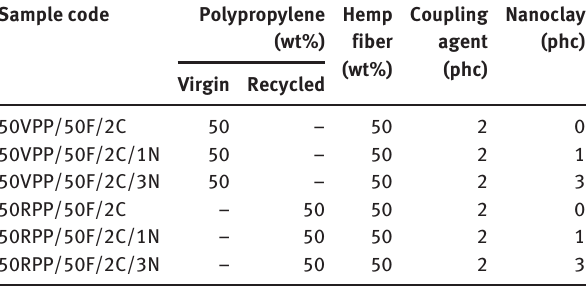
Table 1 Compositions of the studied